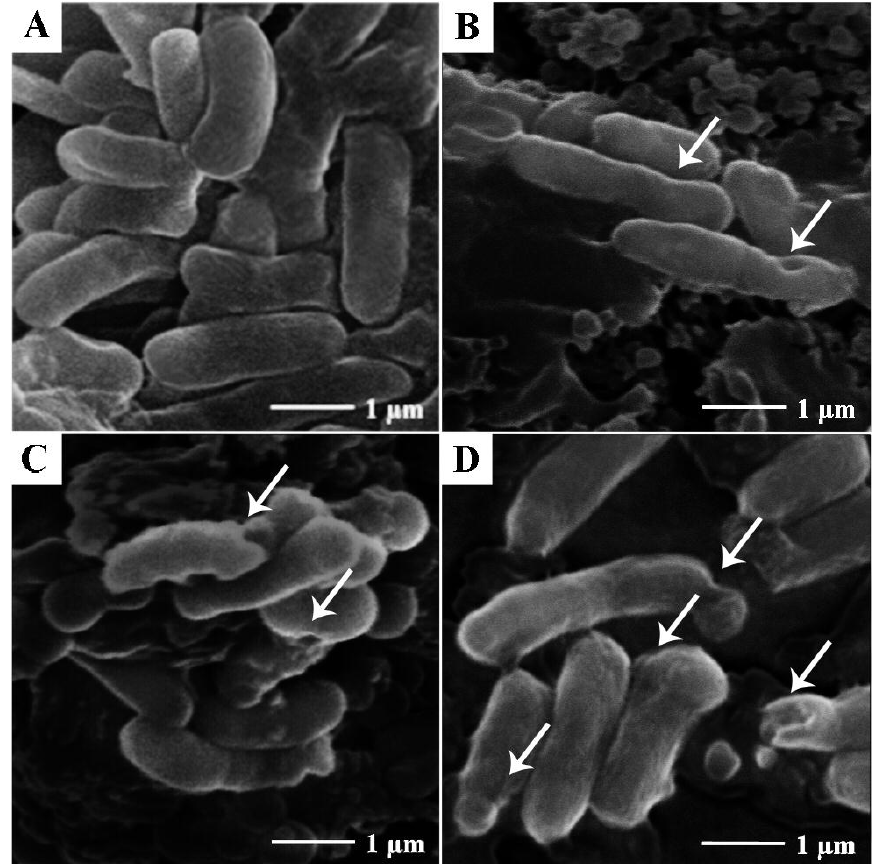
Figure 4. Comparative absorbance of treated K. pneumoniae BAA-1705 subjected to 0.85% saline solution and 0.1% SDS influx.